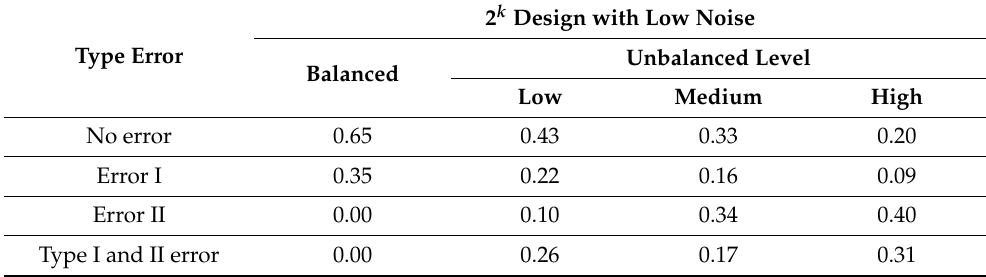
Table 11. Values for different levels of unbalance with low noise.